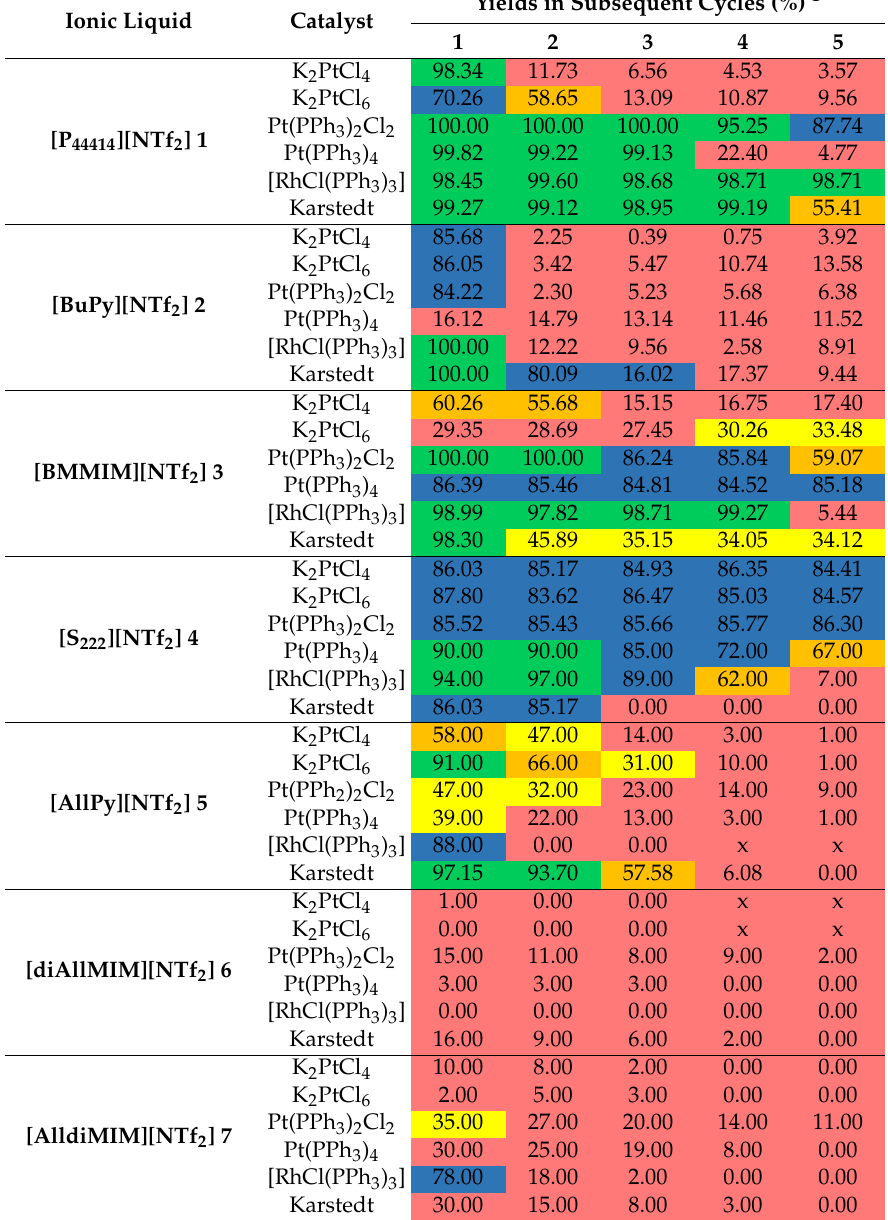
Table 1. Yields of hydrosilylation reaction in subsequent cycles for biphasic systems of ionic liquids and catalysts used. Yields in Subsequent Cycles (%) Ionic Liquid Catalyst